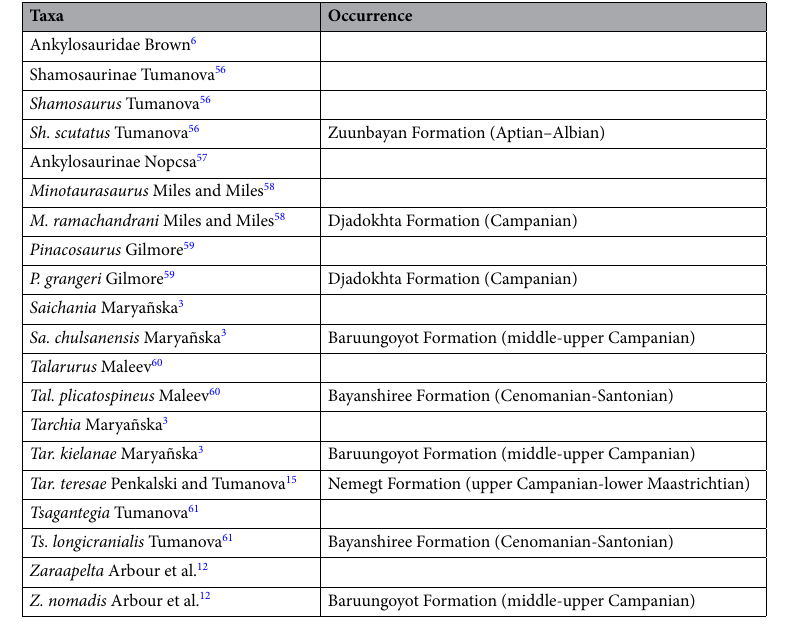
Table 1. Ankylosaur taxa of